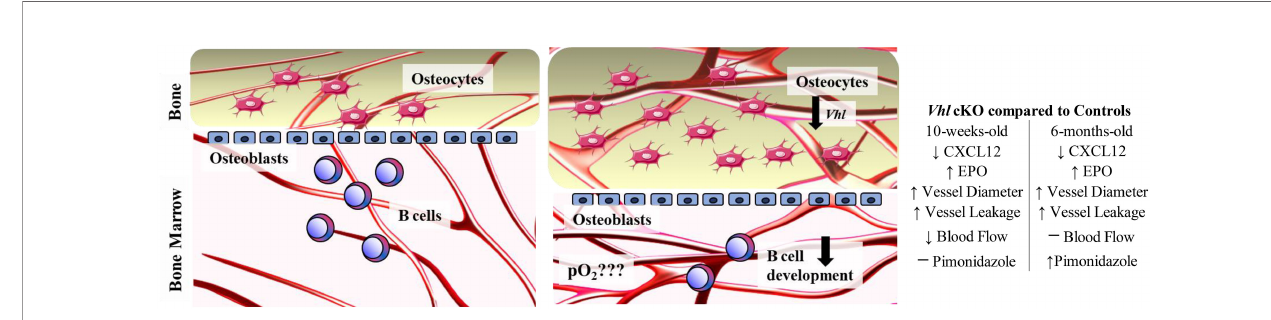
FIGURE 9 | Working model describing the changes in the bone marrow microenvironment in Vhlc KO mice. Left panel: Schematic of healthy control bone marrow where VHL/HIF signaling is intact, the transition from osteoblasts to osteocytes is homeostatically balanced and interactions of developing B cells and stromal cells within their niches promotes their differentiation, maturation and proliferation. Right panel: Lack of Vhl in late osteoblasts and osteocytes has a severe effect on hematopoiesis in the bone marrow, changing the B cell niche and indirectly regulating B cell development through decrease of CXCL12, increase of EPO and changes to the BM microenvironment vasculature and permeability. Changes in the oxygen levels in the local niches for Fraction A cells do not occur until later ages, as shown by pimonidazole staining. Direct measurement of pO 2 in the BM is necessary to determine if the BM oxygenation landscape is altered compared